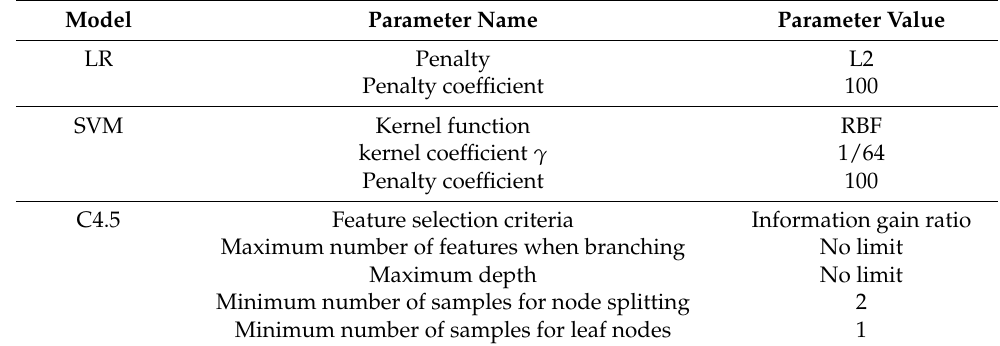
Table 1. Table of the model